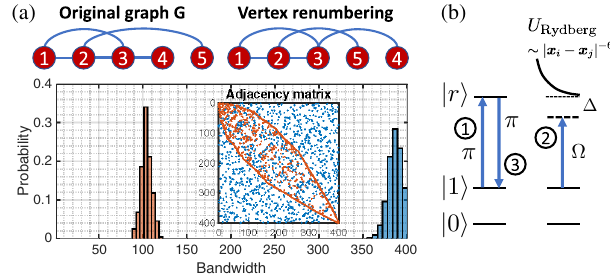
FIG. 8. (a) Vertex renumbering to reduce the graph bandwidth. Top: An example of vertex renumbering for a five-vertex graph. Bottom: Distribution of graph bandwidths for 1000 random 3-regular graphs with N ¼ 400 each. The blue (orange) bars are the bandwidth before (after) vertex renumbering. The inset shows the sparsity pattern of the adjacency matrix before and after vertex renumbering for one particular graph. (b) A protocol to use a Rydberg-blockade controlled gate to implement the interaction term exp ð − i γσ z i σ z j Þ . By choosing a proper gate time ffiffiffiffiffiffiffiffiffiffiffiffiffiffiffiffiffi p Ω 2 þ Δ 2 for the second step ð t ¼ 2 π = Þ , one does not populate the Rydberg level j r i . With tunable coupling strength Ω and detuning Δ , one can control the interaction time γ